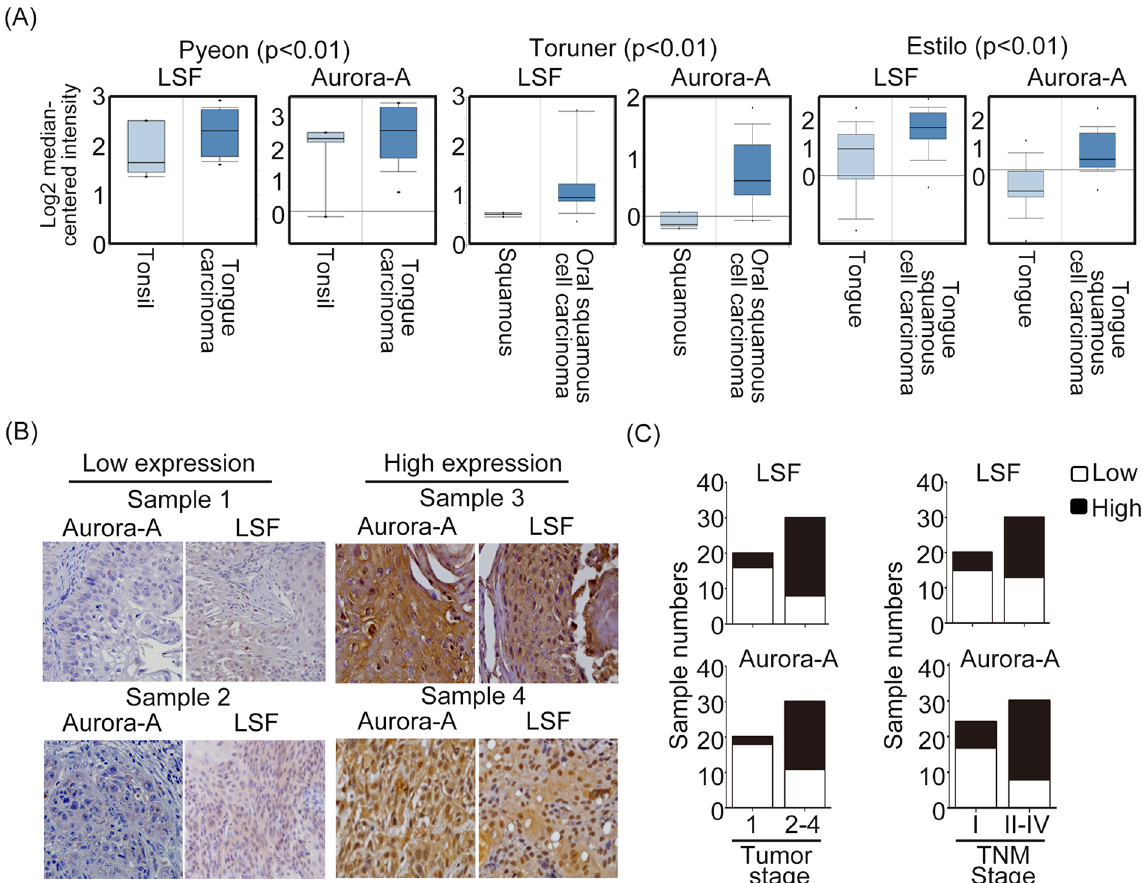
Figure 8. LSF expression positively correlated with Aurora-A expression in human oral cancer specimens. ( A ) Box plots representing Aurora-A and LSF expressions from oral tumor samples at the same databases. Oncomine was used for analysis and visualization. ( B ) Immunohistochemical staining of Aurora-A and LSF in oral cancer tissues showed that Aurora-A expression was positively correlated with LSF expression. ( C ) Statistical analysis showing that LSF expression levels in oral cancer specimens was significantly correlate with tumor and TNM stages.